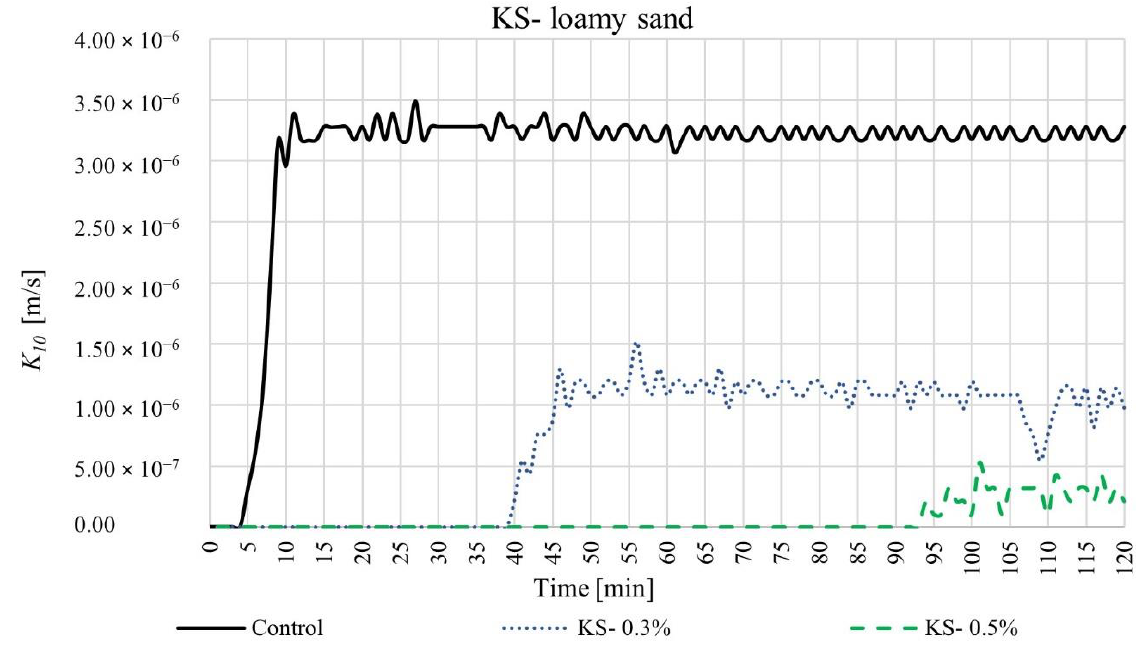
Figure 5. Time-dependent values of coefficient of permeability for SAP-KS and loamy mixtures, in proportions of 0.3, 0.5, and 1.0%.